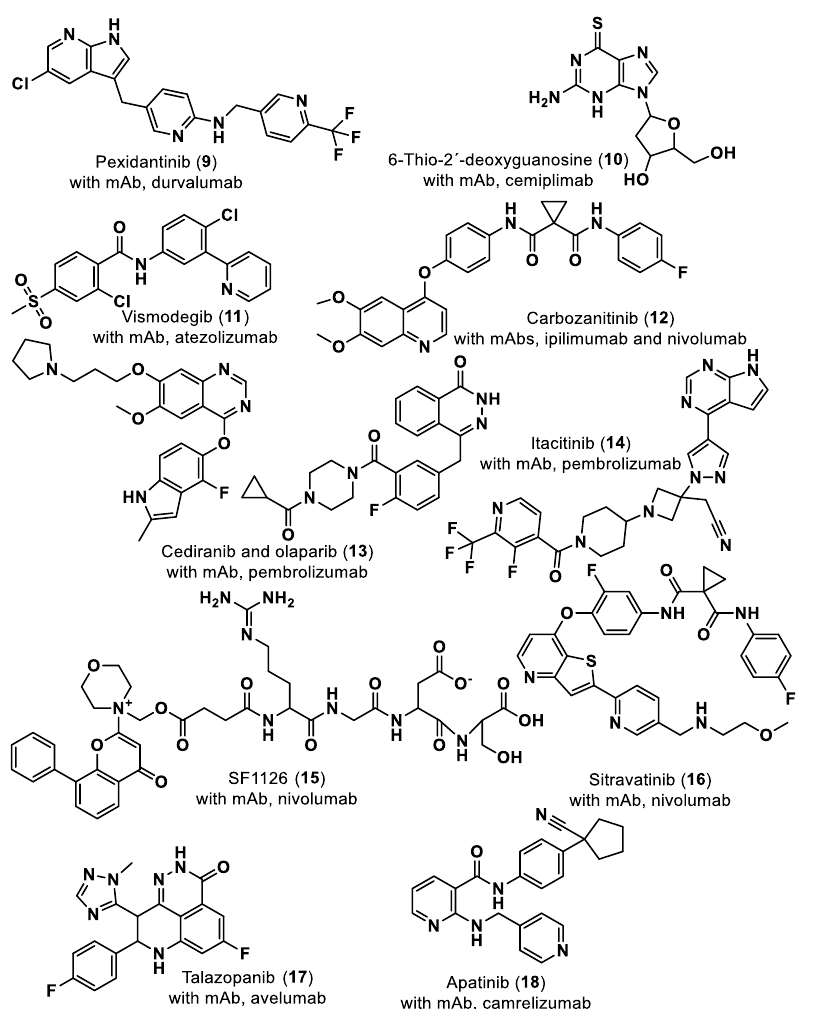
Figure 3. Small molecule ( 9 – 18 ) ICIs targeting PD-1/PD-L1 in combination clinical trials with mAbs.